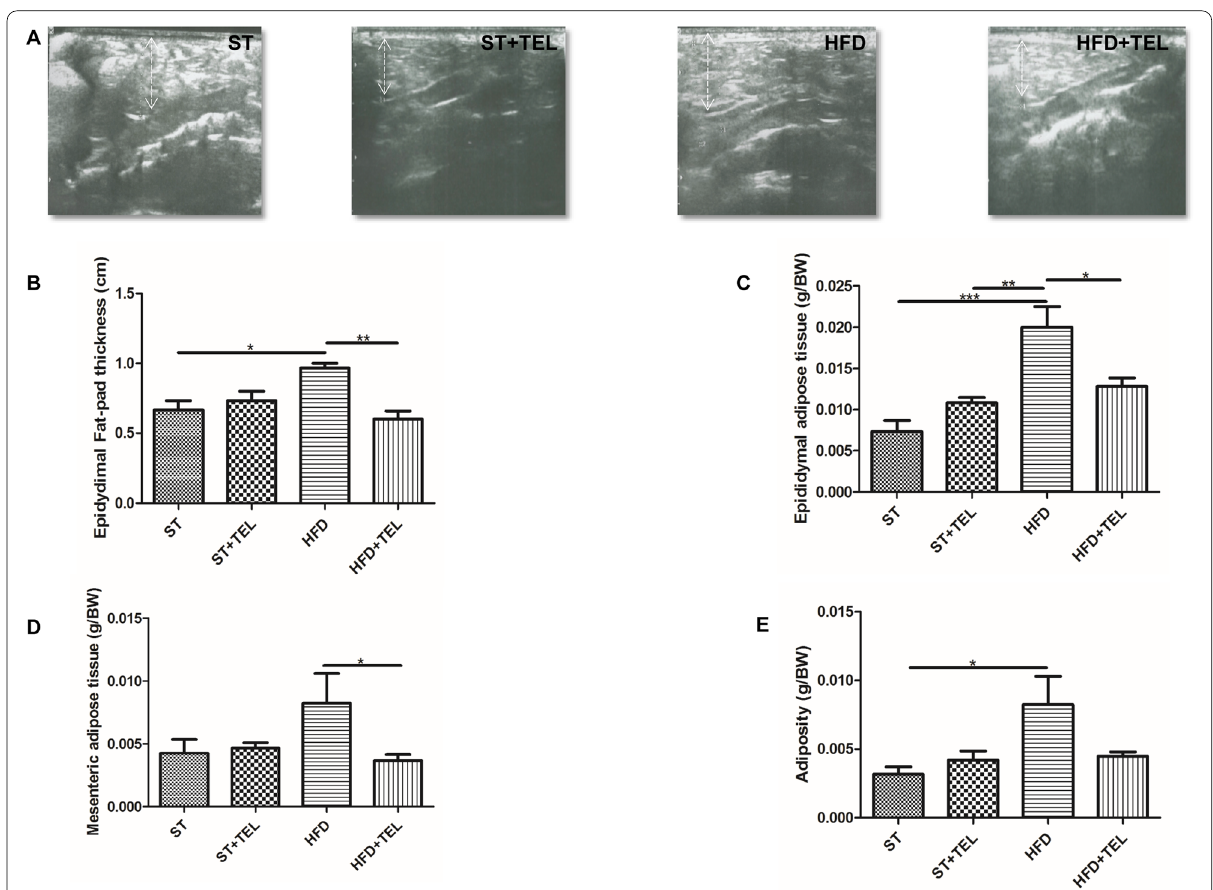
Fig. 2 Adiposity, epididymal, and mesenteric adipose tissues in mice treated with Telmisartan and fed with a standard and high-fat diet (ST, ST HFD, HFD TEL). Epididymal US images ( a ), epididymal fat pad thickness accessed by US ( b ), epididymal adipose tissue weight ( c ), mesenteric + adipose tissue weight ( d ), and adiposity ( e ). Arrows in A indicate the epididymal fat pad. Data are presented as mean